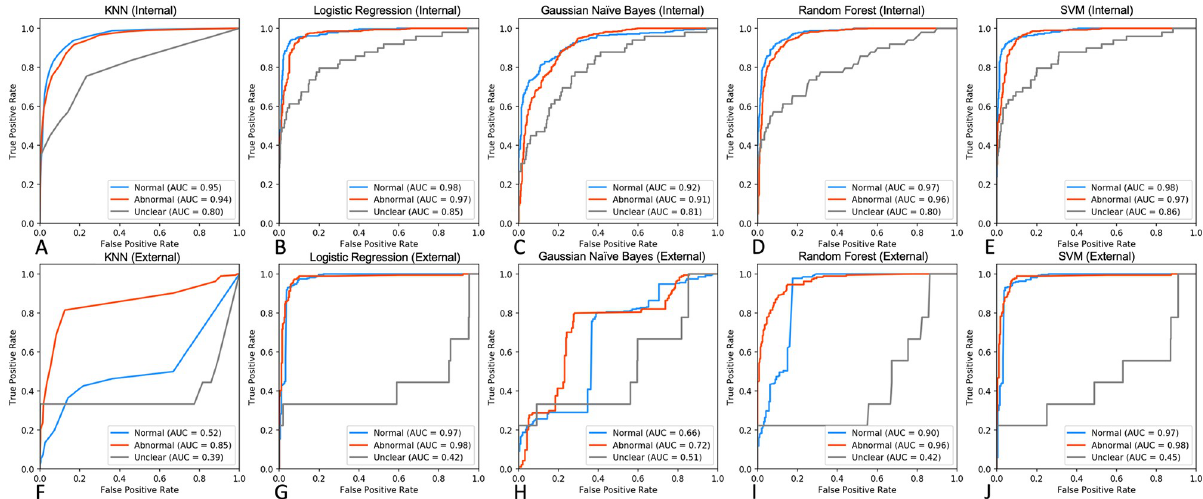
Fig 3. Performance assessment of non-neural classifiers on internal and external testing sets. A-E. ROC curves displaying performance metrics on an expert-labelled internal testing set (n = 329 Normal, n = 601 Abnormal, n = 35 Uncertain). F-G. ROC curves demonstrating classifier performance on external MIMIC-CXR free-text reports (n = 272 Normal, n = 184 Abnormal, n = 9 Uncertain).